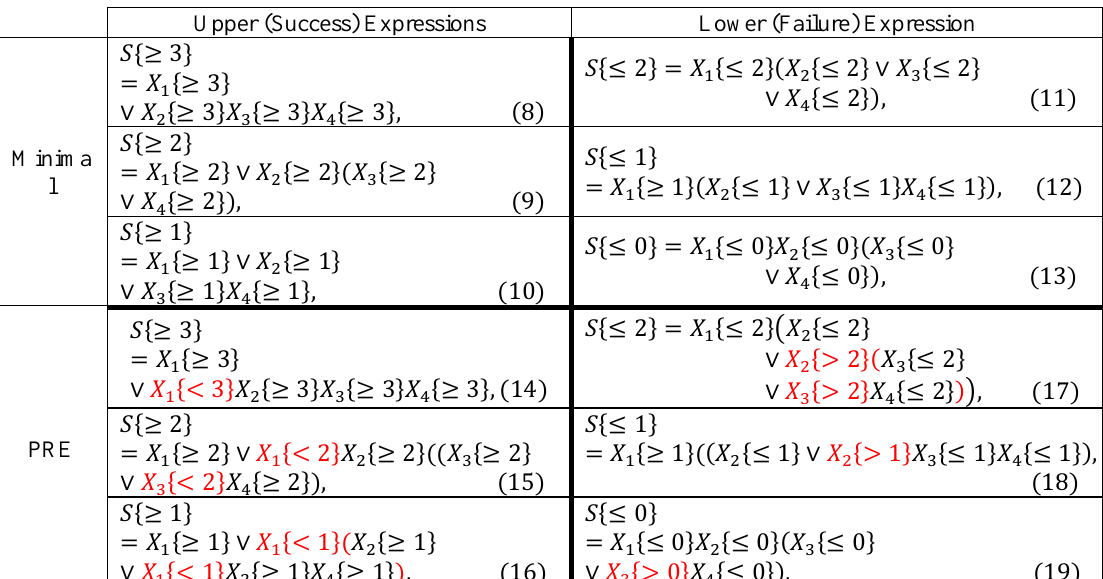
Table 1. A listing of minimal and PRE expressions of system success and failure at each non-zero level 𝑗 (𝑗 = 1, 2, 3) . Crossing the vertical axis of the table from left to right involves complementation, while crossing the horizontal axis of the table from top to bottom involves orthogonalization (disjointing of